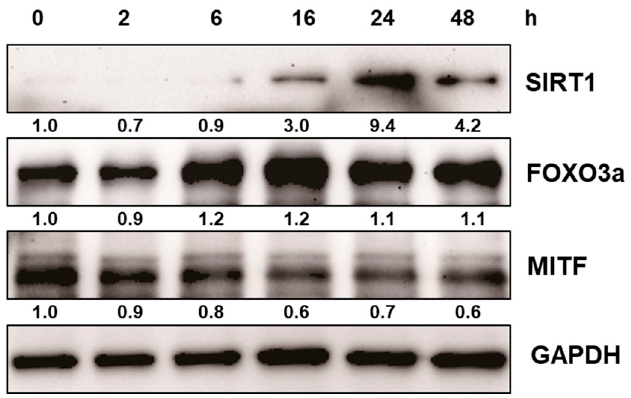
Figure 4. Time-dependent changes of SIRT1 and FOXO3a were investigated after treating normal human melanocytes with 50 μ M of resveratrol.